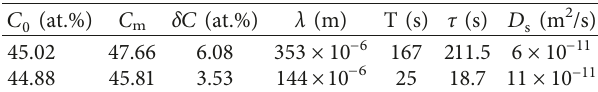
Table 1: Values of physical parameters used for calculating dif- fusion coefficient and the